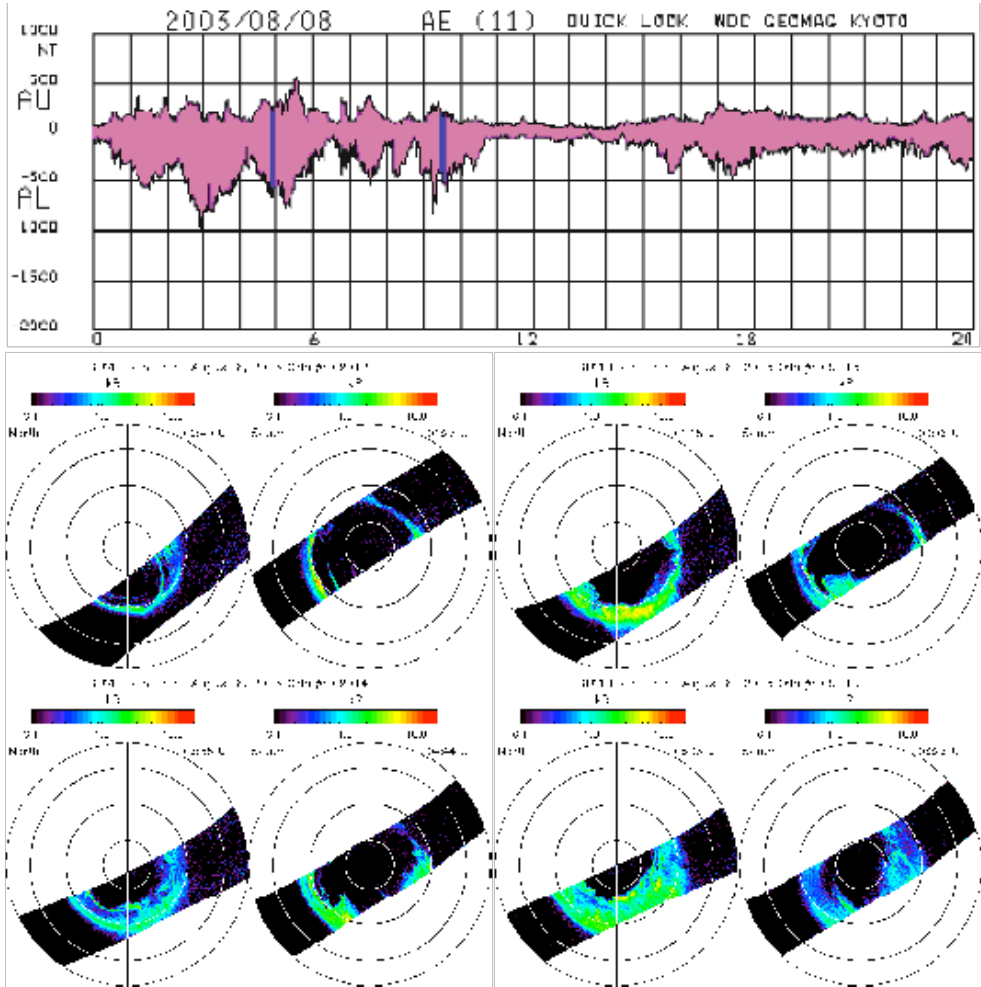
Figure 1 Fig. 1. The AU (upper) and AL (lower) indices on 8 August 2003 and the sequence of global auroral images from TIMED as it crossed over